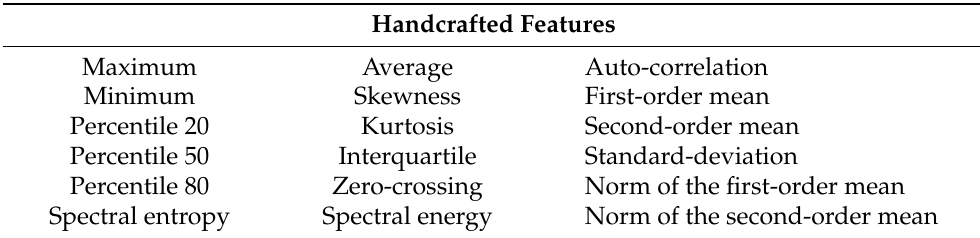
Table 2. List of the handcrafted features used in our study. Each feature is computed on each sensor channel